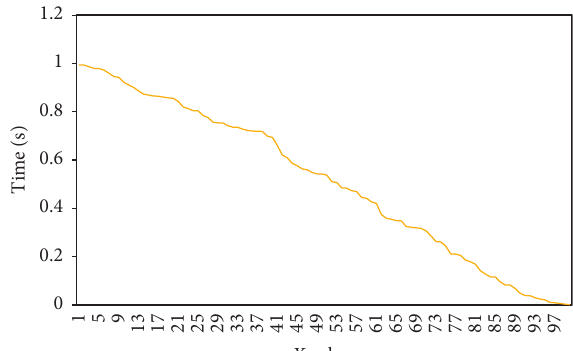
Figure 1: Standard Internet of Health Things system attenuation term x .